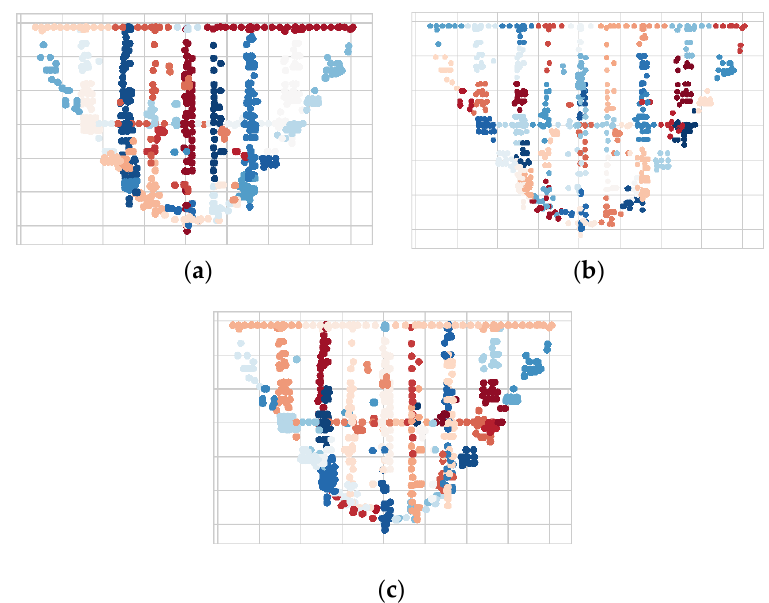
Figure 7. Network partition results for dam safety monitoring system ( a ) NPA; ( b ) TSDA+K-Means; ( c ) TSDA+ Gaussian mixture model (GMM).